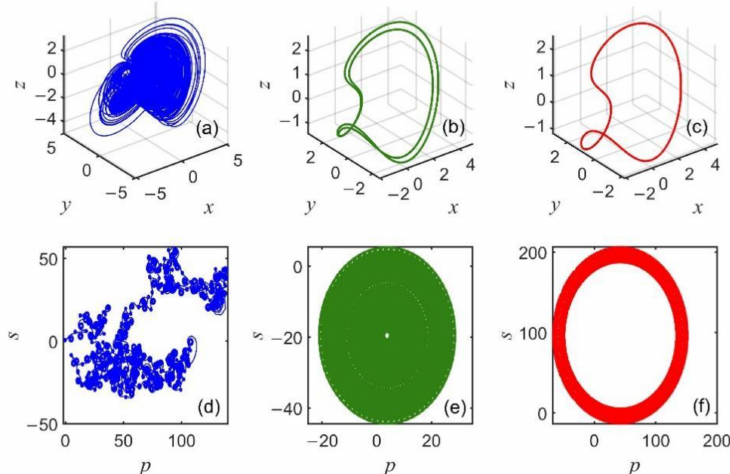
Figure 4. Phase portraits and p − s plots of system (14) for q = 0.95. ( a ) a 1 = 0.3; ( b ) a 1 = 0.85; ( c ) a 1 = 1; ( d ); a 1 = 0.3; ( e ) a 1 = 0.85; ( f ) a 1 = 1.